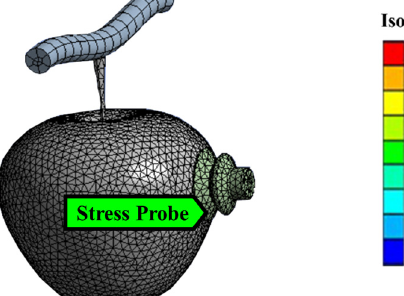
Figure 24. Contact stress under the apple surface at different vacuum levels.